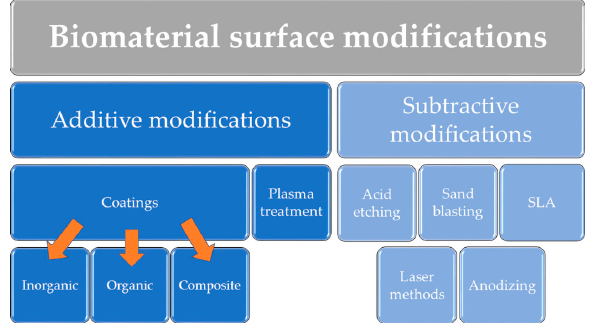
Figure 2. Scheme presenting various types of possible surface modifications of biomaterials for bone tissue engineering and regenerative medicine applications aiming to improve their osteoconductive and osteoinductive